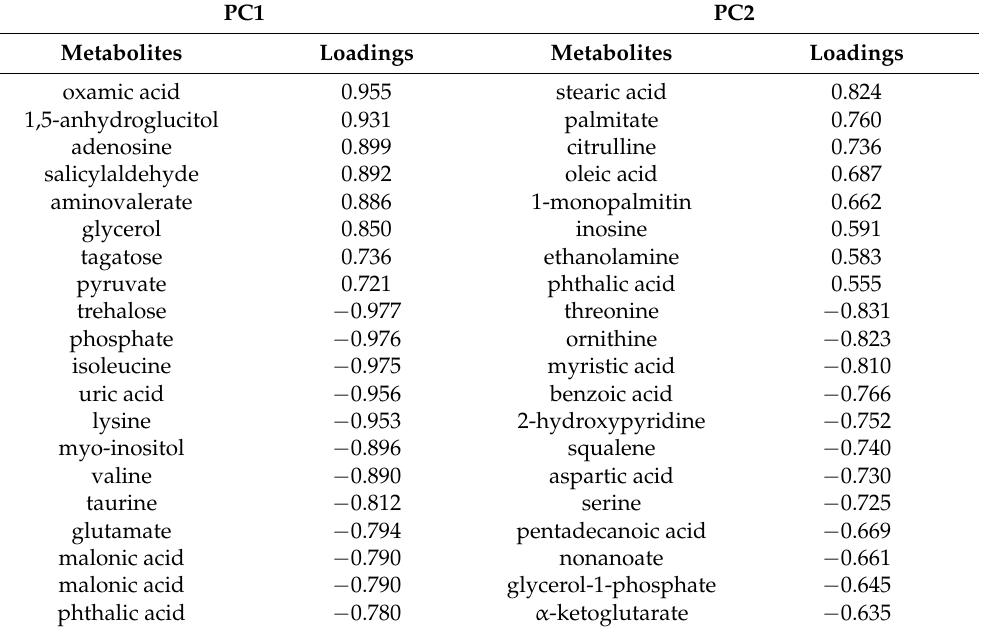
Table 3. Identified metabolites with high absolute loadings on PC1 and